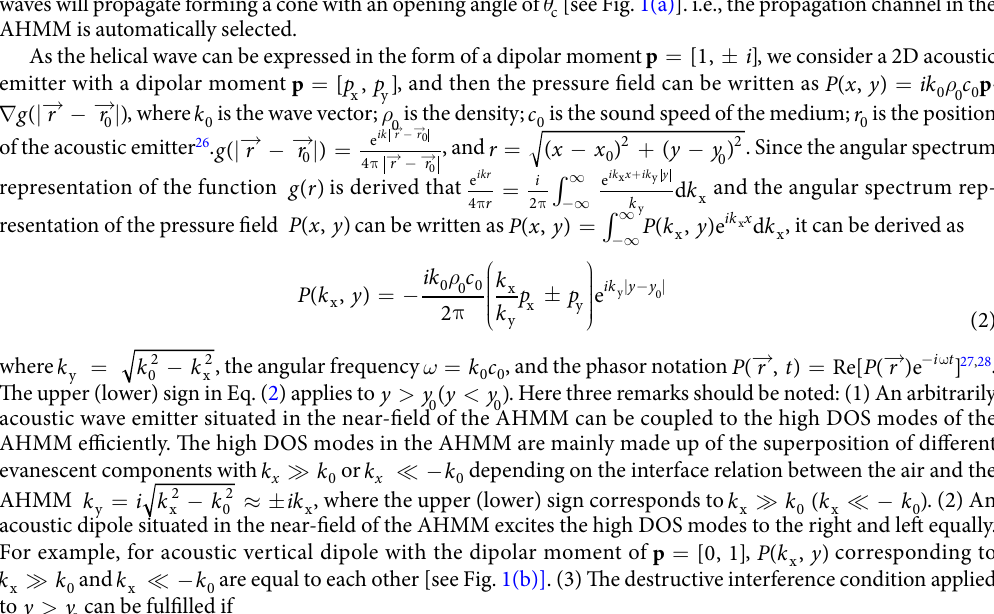
|→ → − | , where k g r r ( ) 0 ∇